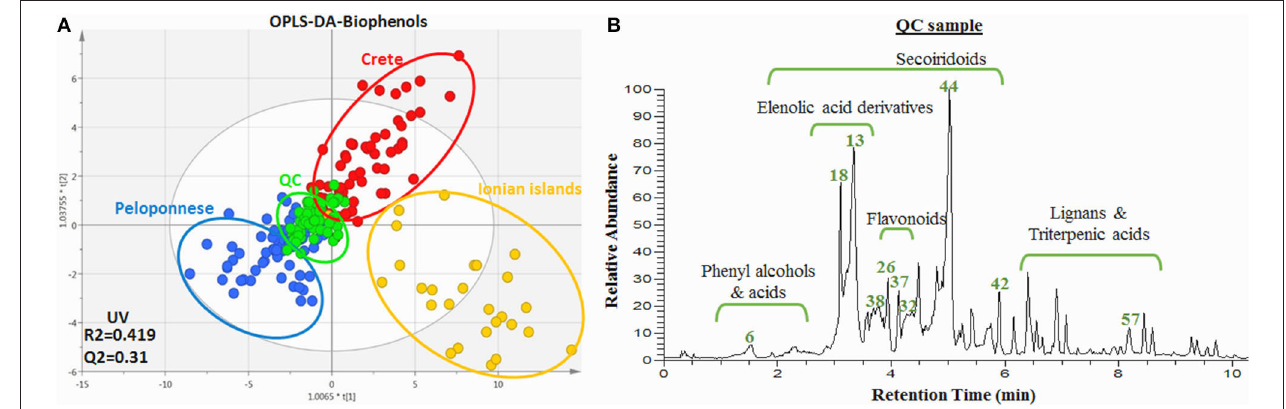
FIGURE 10 | (A) OPLS-DA scores plot of the biophenol extract samples acquired via UPLC-HRMS. Plot includes the total number of observations in color scale according to geographical origin ClassID; Peloponnese (blue), Crete (red), Ionian islands (yellow). QC sample are also included (green). R2/Q2 model parameters are annotated (bottom-left). (B) Base peak (BP) chromatogram of the QC (pooled sample). Certain metabolites are annotated. samples in PC1 and between them in PC2. QC